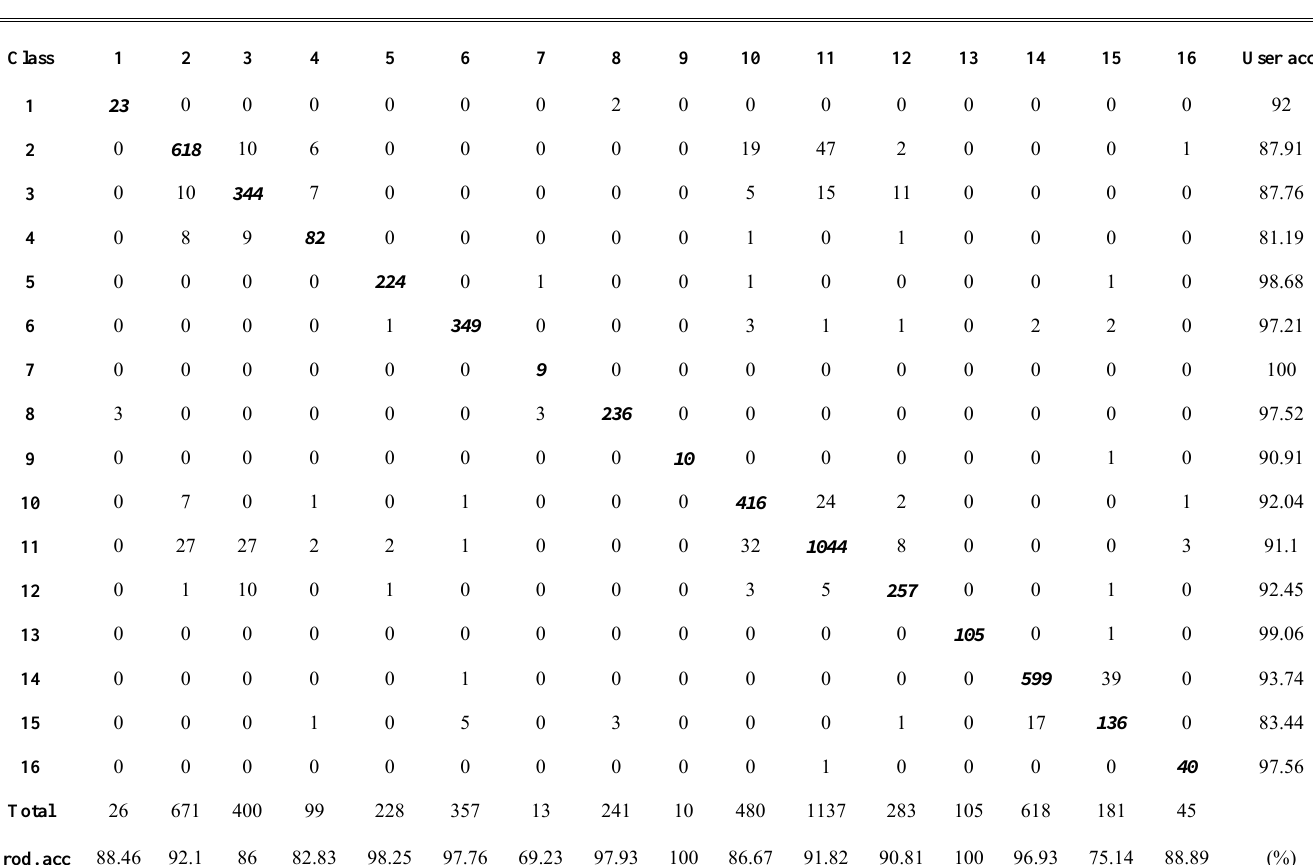
Table 1. Results of the confusion matrix.